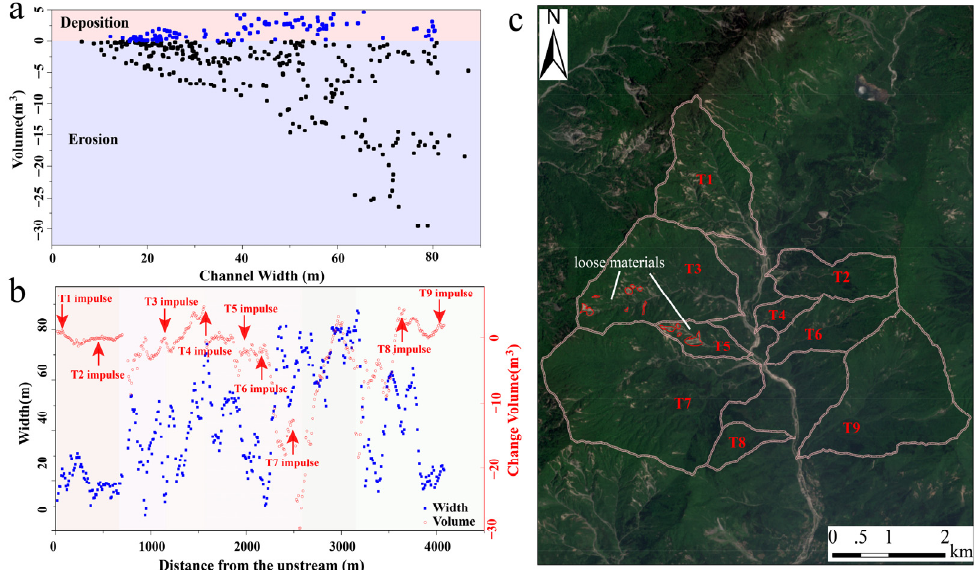
Figure 8. Effect of the channel width and impulse of tributaries to the volumetric change post-flash flood. ( a ) shows the relationship between channel width and volume change during a flash flood; ( b ) shows the change of channel width and volume change along the channel with the influence of tributaries inflow; ( c ) shows the distribution of loose materials in different tributaries.